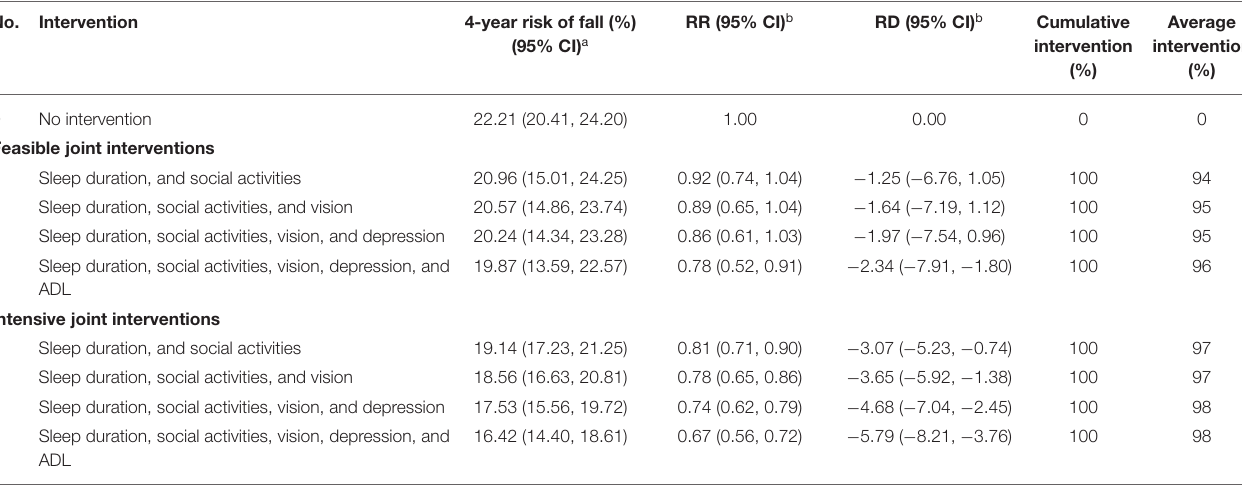
TABLE 7 | Effect of joint hypothetical interventions on 4-years fall risk (CHARLS